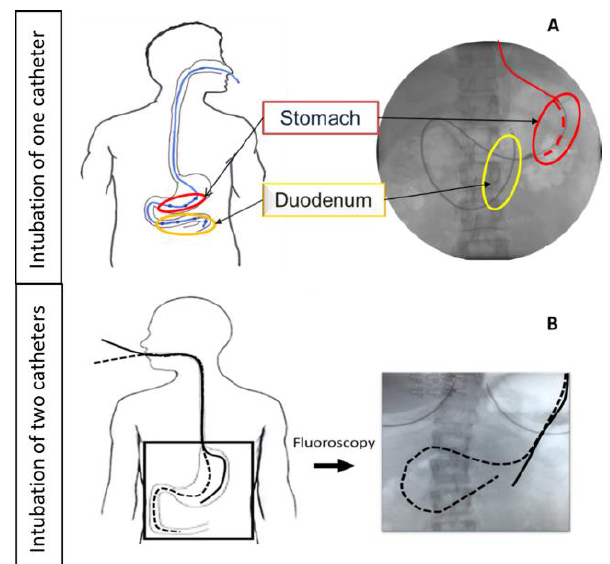
Figure 6. Schematic overview of the clinical aspiration technique — Left: Catheter(s) introduced through the nose ( A ) or mouth ( B ) and positioned inside the stomach and the upper small intestine. Right: X-ray images of ( A ) one catheter positioned inside the stomach and the intestine with aspira- tion/perfusion ports in both segments, and ( B ) a catheter positioned inside the stomach (solid line) and a catheter positioned inside the intestine (dotted line); catheters are traced for clarity. Adapted from European Journal of Pharmaceutical Sciences , 134, Vertzoni et al., “Impact of regional differences along the gastrointestinal tract of healthy adults on oral drug absorption: An UNGAP review”, 153–175, [3]. Copyright Elsevier (2019).